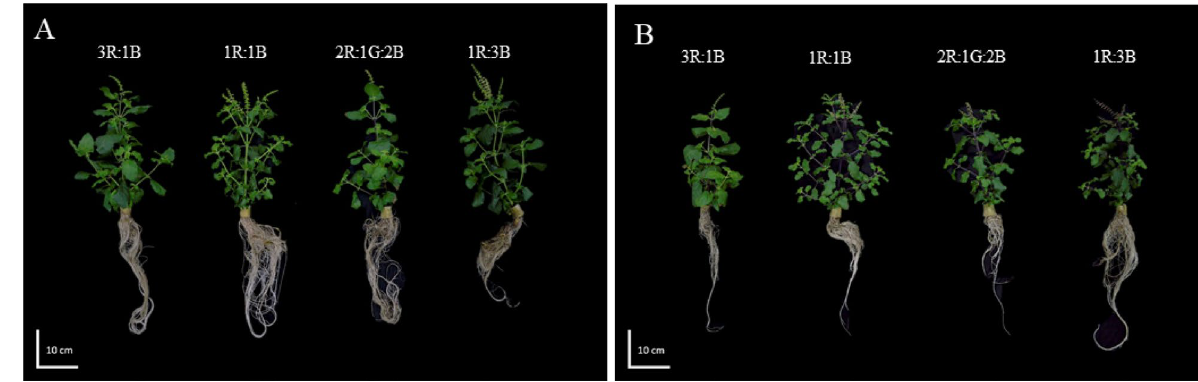
Figure 2. The phenotypes of green holy basil ( A ) and red holy basil ( B ) under four light treatments (3R:1B, 1R:1B, 2R:1G:2B, and 1R:3B) at flowering stage. R, G and B represent the red, green and blue llight spectra, respectively, and number before the letters stand for the ratio of each lighrt